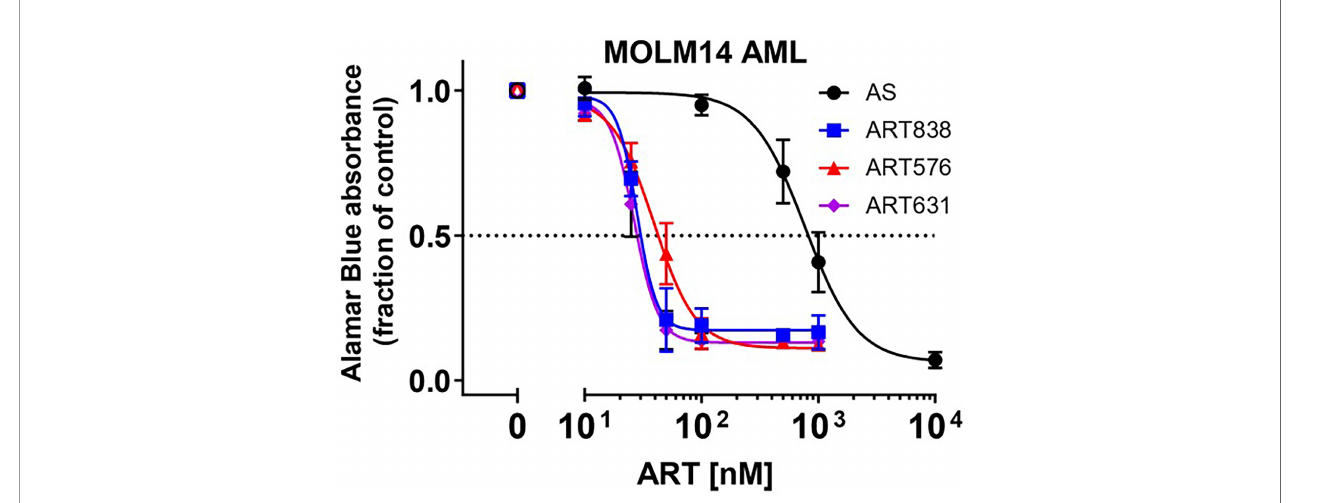
FIGURE 2 | 2C-ARTs ART631 and ART576 potently inhibited the growth of MOLM14 AML cells, with activity comparable to ART838. In this experiment, provided to show the entire concentration:response range, MOLM14 AML cells were cultured with a range of concentrations of artesunate (AS), ART838, ART631, and ART576 for 48h. Graph indicates growth inhibition relative to vehicle (DMSO)-treated controls by alamarBlue absorbance assays. Data points and error bars represent mean and SD of 3 independent experiments done in triplicate. Although Table 1 shows only IC 50 s, this full concentration:response range was assessed for all 10 AML cell